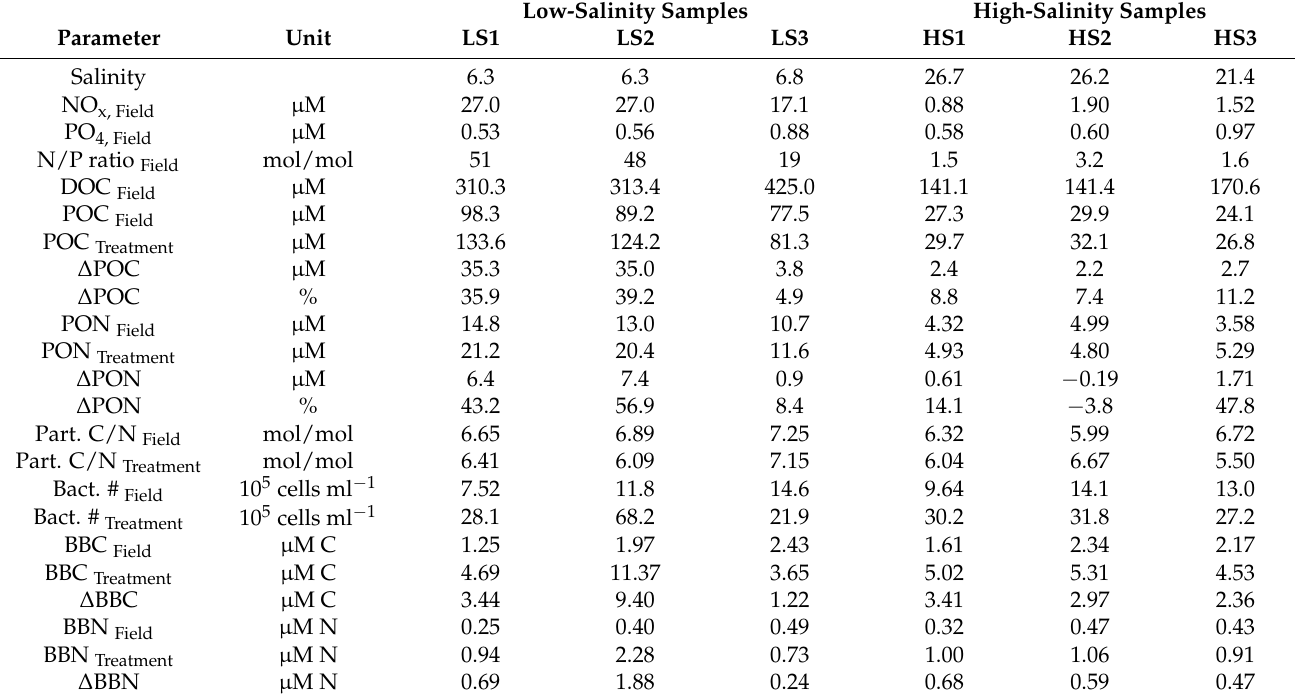
Table 1. Environmental conditions and chemical and biological parameters. Abbreviations: NO x : nitrate + nitrite; DOC: dissolved organic carbon; POC: particulate organic carbon; PON: particulate organic carbon; Part: particulate; Bact: bacteria; BBC: bacterial biomass in C; BBN: bacterial biomass in N; LS: low-salinity; HS: high-salinity. The estimate of BBC is based on the bacterial cellular C content of 20 fg and the estimate of BBN is based on a bacterial C:N ratio of 5. Treatment denotes samples after two days of rolling.